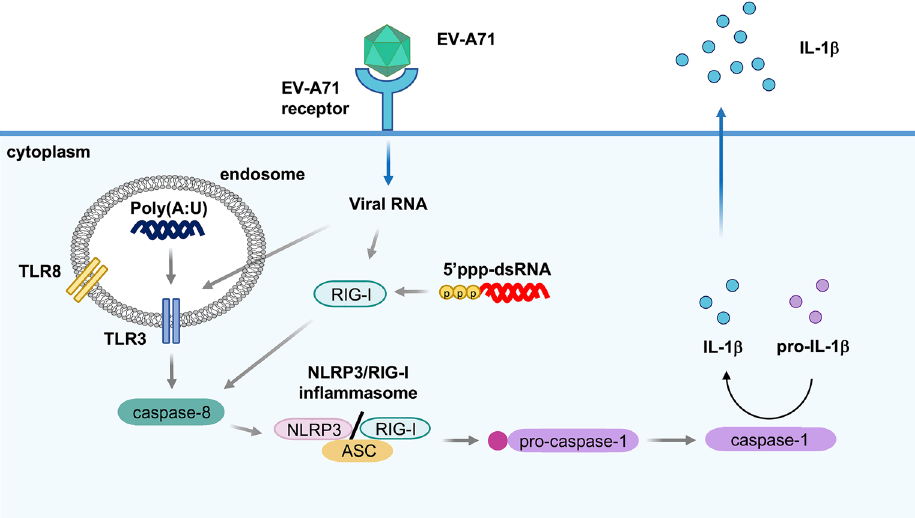
Figure 8. Mechanism of EV-A71 vRNA-triggered NLRP3-, RIG-I-inflammasome. Following the EV-A71 infection, TLR3 recognized EV-A71 vRNA and induced caspase-8 activation. The activation of caspase-8 promote the NLRP3-ASC and RIG-I-ASC assembly, and cleavage of caspase-1 cleavages pro-IL-1β to mature